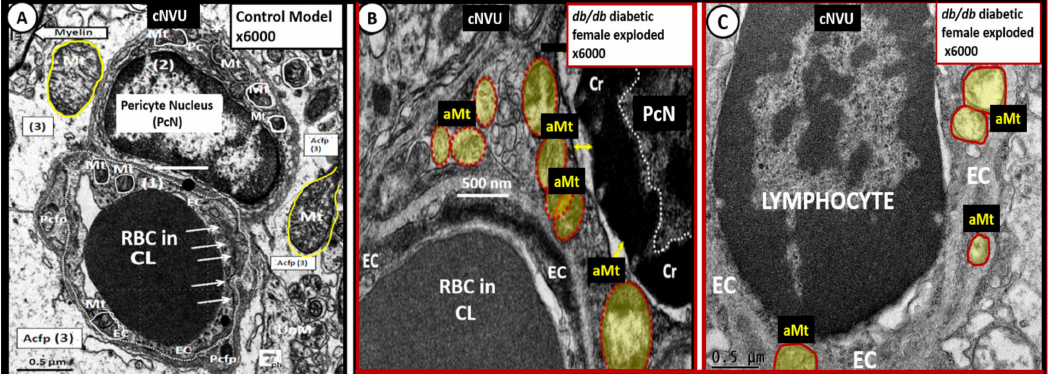
Figure 10. The mural pericyte (Pc) and endothelial cell (EC) of the capillary neurovascular unit (NVU) develop remodeled aberrant mitochondrial (aMt) in the 20-week-old female diabetic db/db models. Panel A demonstrates the normal electron-dense mitochondria (Mt) in the Pc and EC (outlined with white lines) in the cytoplasm. Additionally, note the arrows pointing to the tight and adherens junctions and normal electron-dense Mt in the astrocyte foot processes (outlined in yellow). Panel B depicts the aMt (pseudo-colored yellow outlined in red) in the Pc cytoplasm as compared to the normal Mt in panel A . Panel C depicts the aMt in the EC (pseudo-colored yellow outlined in red) as compared to the normal Mt in panel A. Note the excessive chromatin (Cr) condensation in the Pc nucleus. Panels B and C are exploded cropped images and these images were observed during the studies in references [32–36] provided by CC 4.0. Original magnification × 6000 exploded with intact scale bars of 500 nm ( panel B ) and 0.5 µ m ( panels A and C ). Acfp = astrocyte foot process; CL = capillary lumen; Pcfp = pericyte foot processes; PcN = pericyte nucleus; RBC = red blood